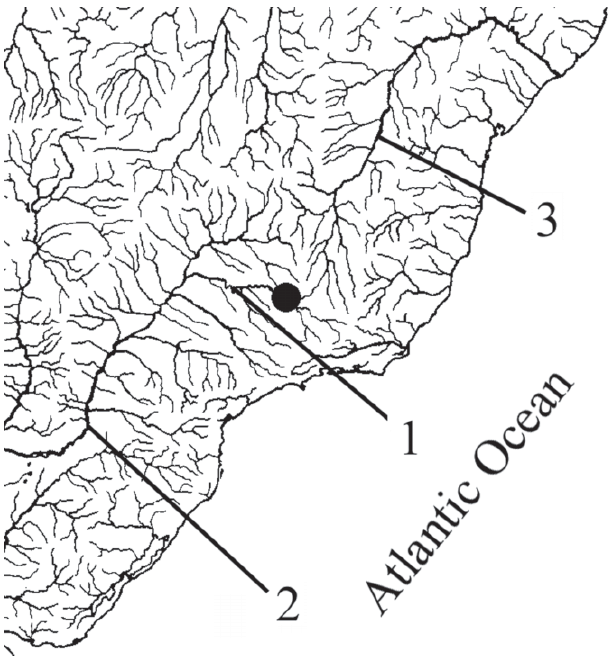
Fig. 3 . Map of part of the eastern coast of South America and adjoining regions showing the type locality and known distribution of Lophiobrycon weitzmani , new genus and species, in the upper rio Paraná system, southeastern Brazil (1 = rio Grande; 2 = rio Paraná; 3 = rio São